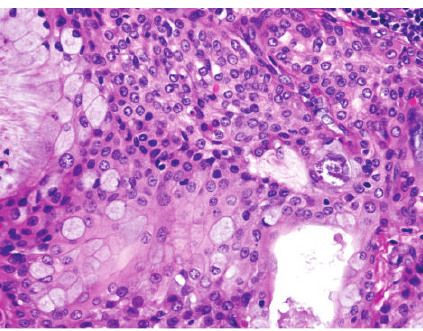
Figure 6: Higher magnification of a more solid focus of the tumor infiltrating outside the lymph node (200x;